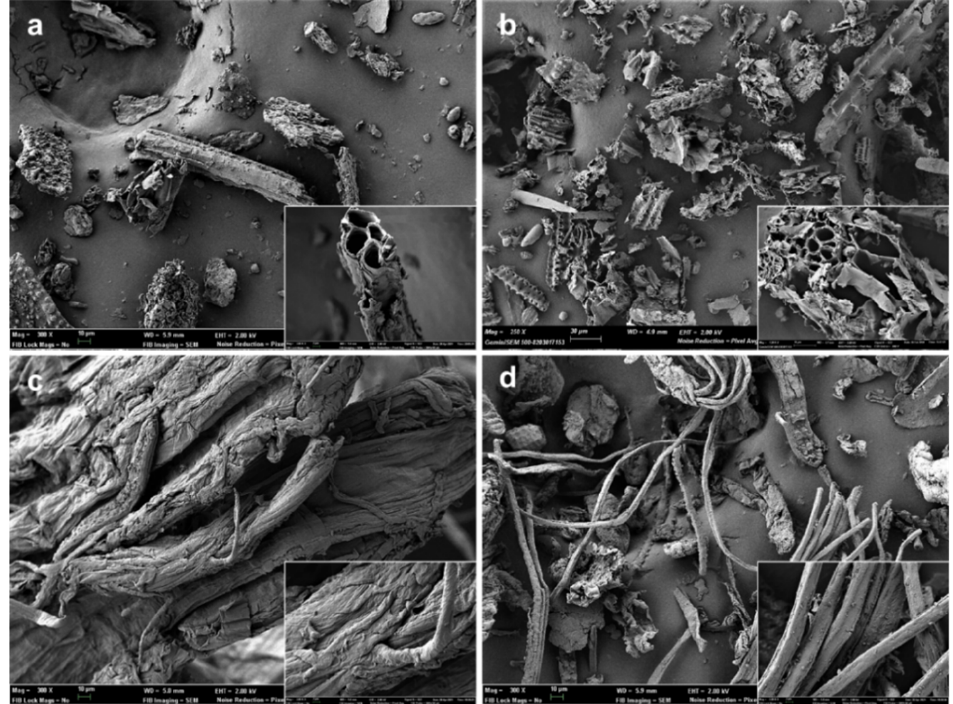
Figure 2. Field emission scanning electron microscope (FESEM) micrographs of untreated rice straw (RS) ( a ), RS treated with combined ultrasound-heating method ( b ), bleached cellulose microfibers (CMFs) before ( c ) and after ( d ) the milling step. Images were taken at 300× with insets at 2000×.